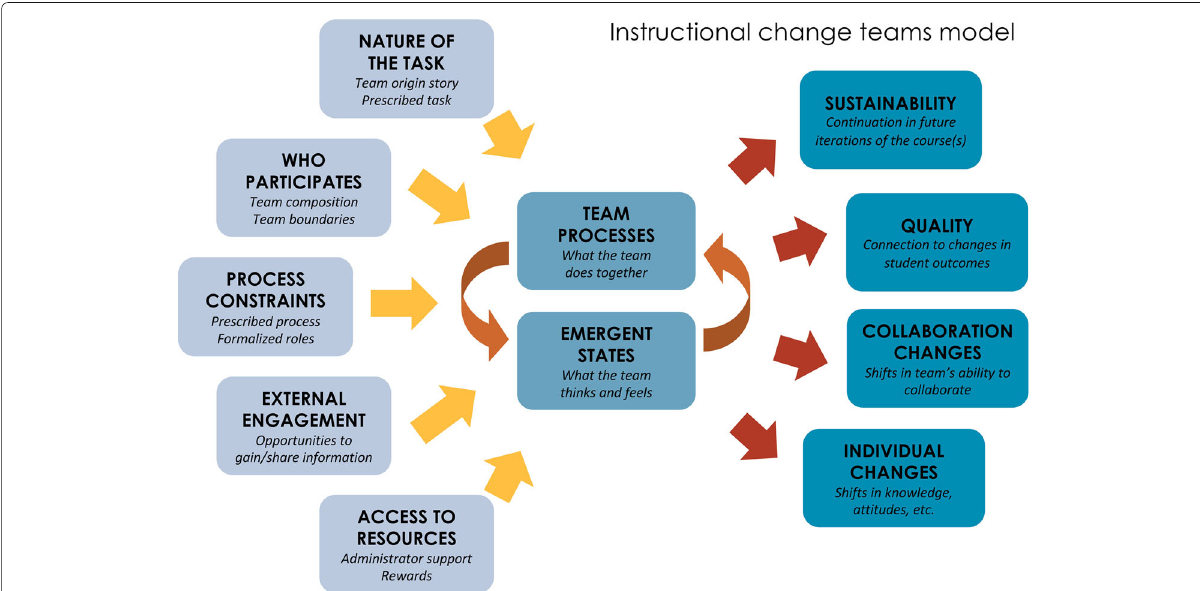
Fig. 1 Instructional change teams’ model. A visual representation of our current model of instructional change teams, based on interviews with project leaders and existing literature. In this model, team inputs (purple, left) lead to mediators (light blue, center), and mediators lead to team outcomes (darker blue, right). The two categories of mediators, team processes and emergent states, are shown as cyclically influencing each other (Marks et al. 2001). See also Table 2 and the “Results” section of the main